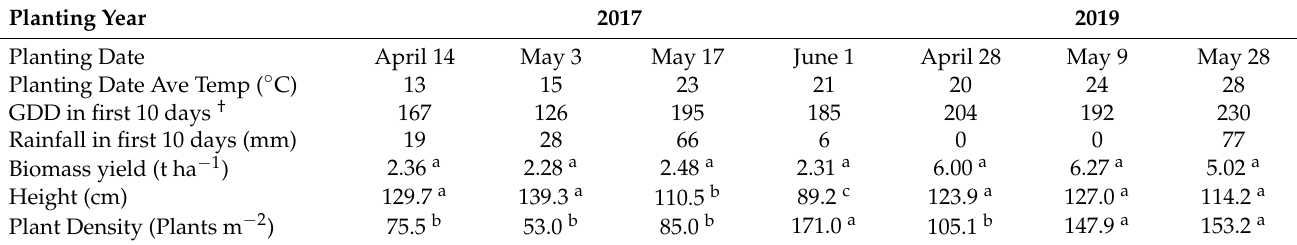
Table 9. Comparison of different character traits of fiber hemp based on their planting date. Planting